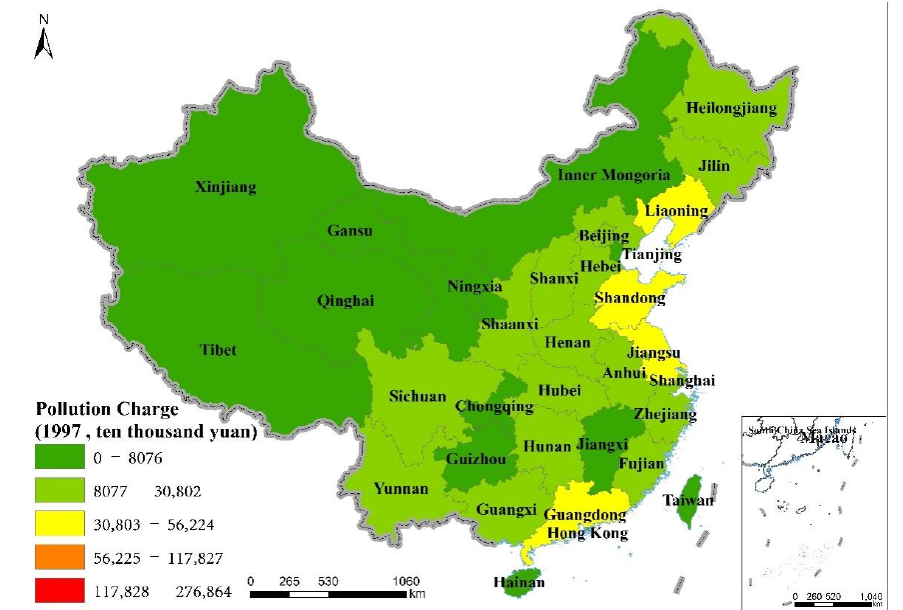
Figure 1. China’s pollution charges in 1997.